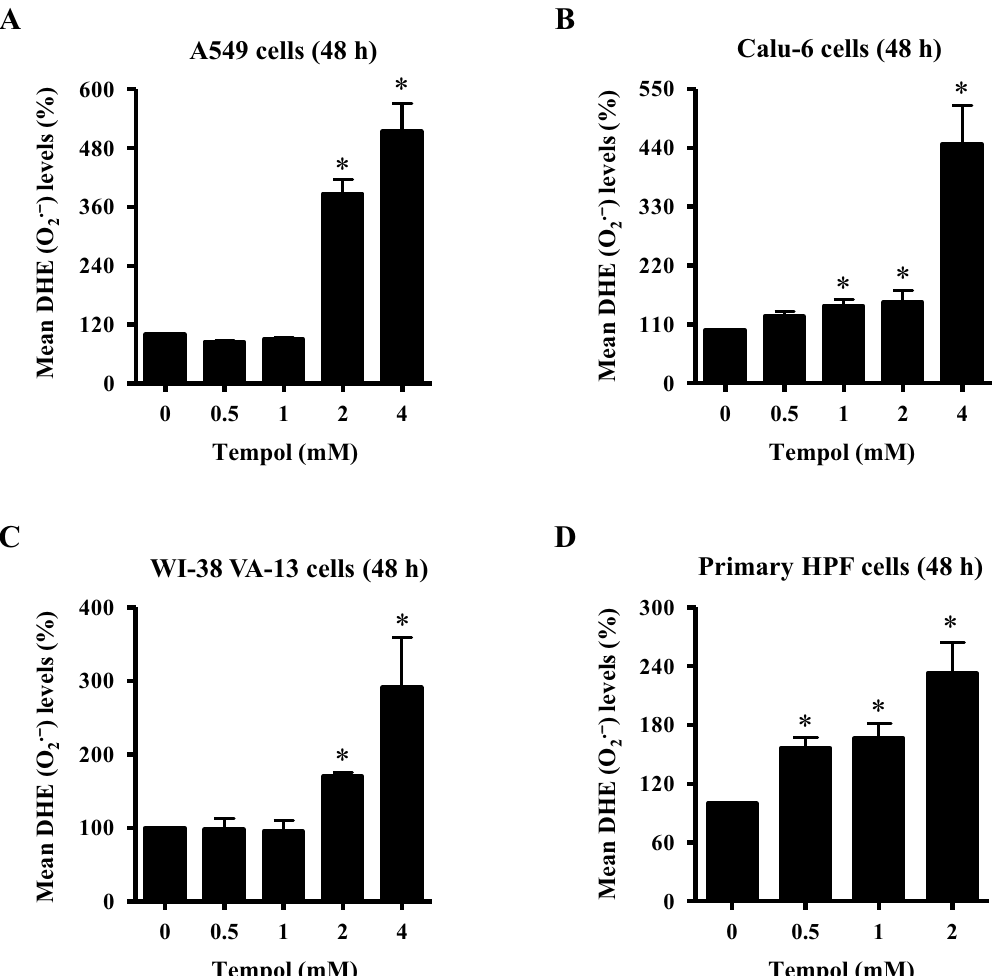
Figure 2. Effects of Tempol on intracellular DHE (O 2 •− ) levels in lung cancer and normal cells. Cells in the exponential growth phase were incubated with the indicated concentrations of Tempol for 48 h. Intracellular DHE